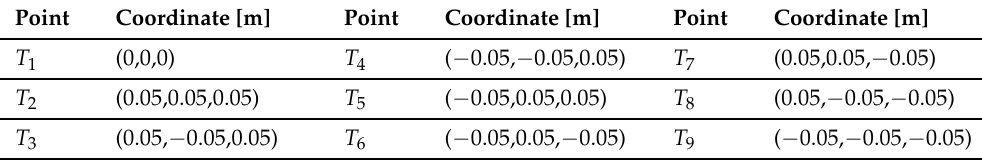
Table 3. Coordinates of the test points parameterized with respect to the center of the LRDW.